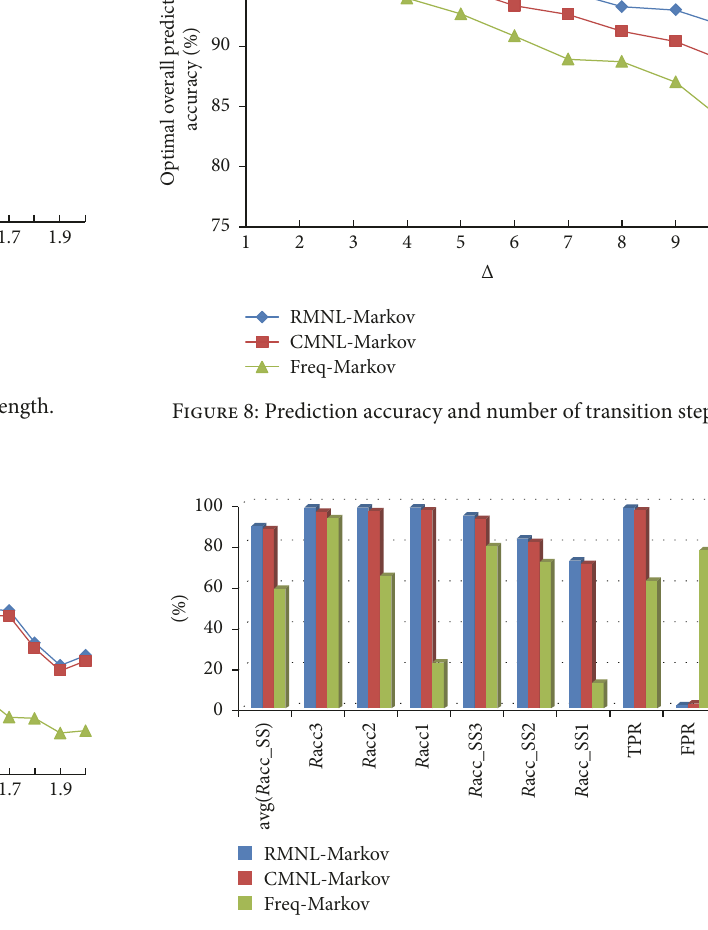
Figure 9: Mean prediction results of the top 10 parameter combina-